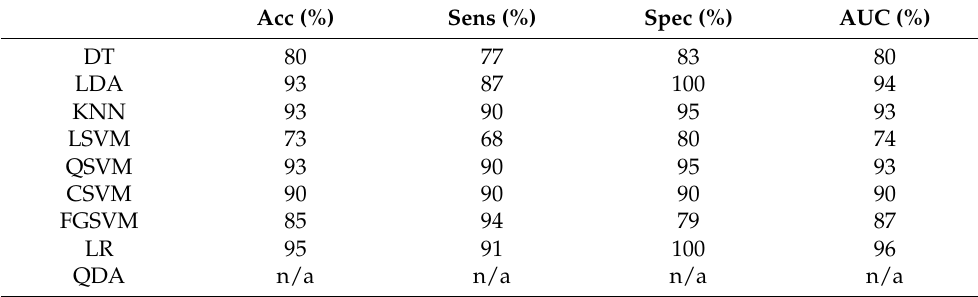
Table 10. Results for the LSDL for Dataset